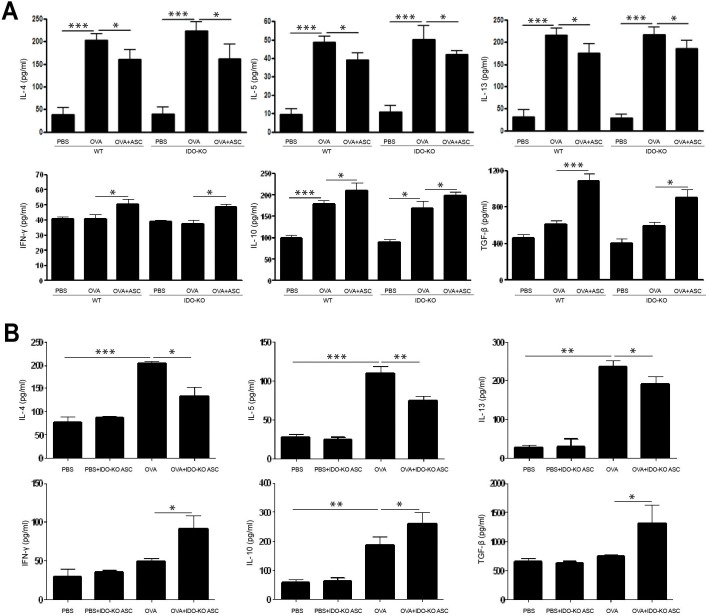
Effect of adipose-derived stem cells (ASCs) on cytokine levels in bronchoalveolar lavage fluid.IL-4, IL-5, and IL-13 levels were significantly higher in the OVA group than PBS group. ASCs (A) or ASCs derived from indoleamine 2, 3-dioxygenase (IDO)-knockout (KO) mice (B) treatment significantly decreased IL-4, IL-5, and IL-13, but increased IFN-γ, IL-10, and TGF-β in WT and IDO-KO asthmatic mice. Data are expressed as the mean ± SEM of four independent experiments performed in triplicate. *
p<0.05, **
p≤0.005, ***
p≤0.001.